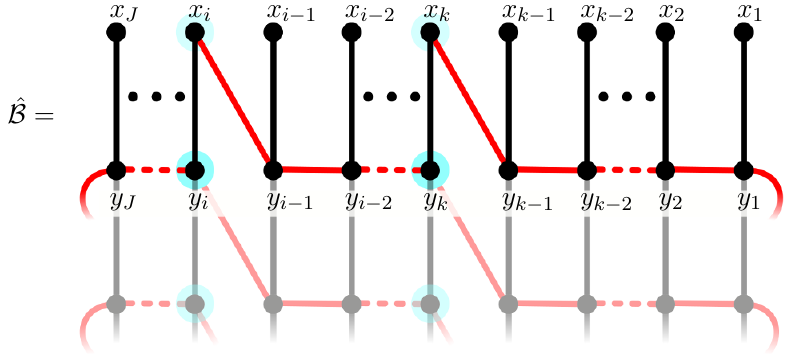
Figure 3 . The graph-building operator ^ B for the state with two magnons. The locations of the magnons are indicated by the blue